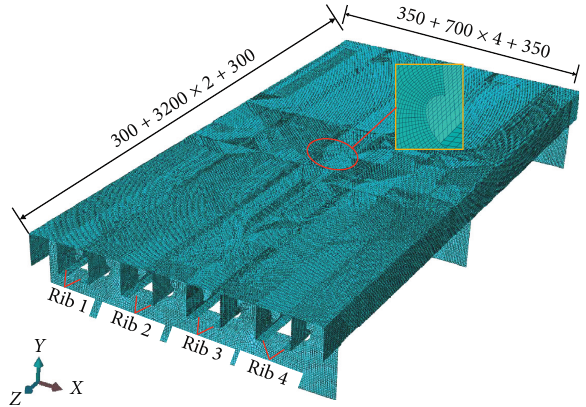
Figure 4: FE model of